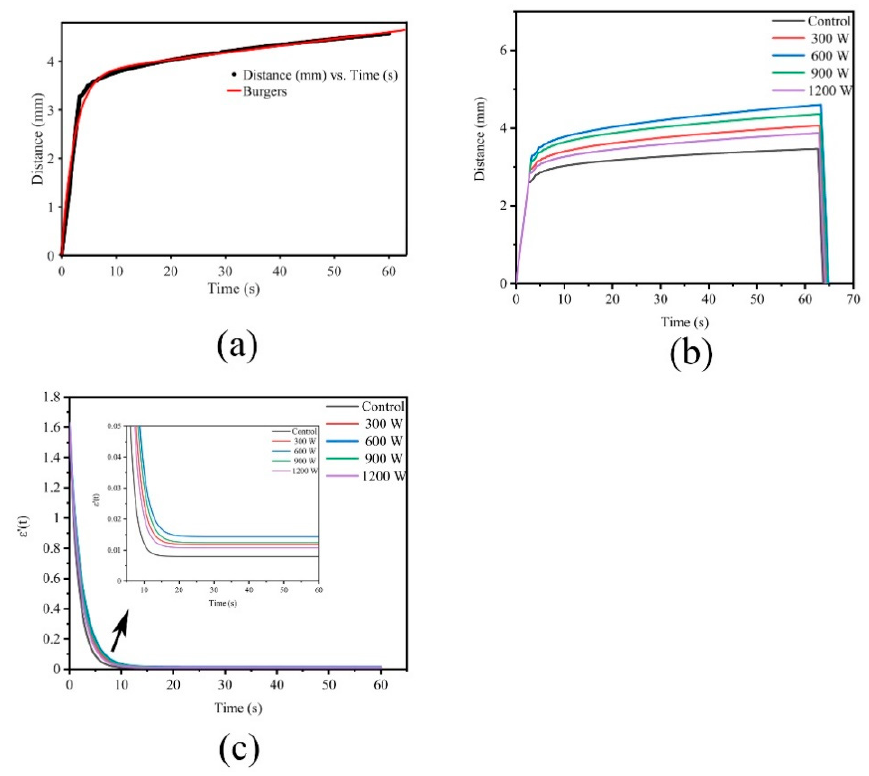
Figure 3. ( a ): Creep fitting; ( b ): Effect of different ultrasound power on creep of WB; ( c ): Effect of different ultrasound power on ε ’ (t) of WB.